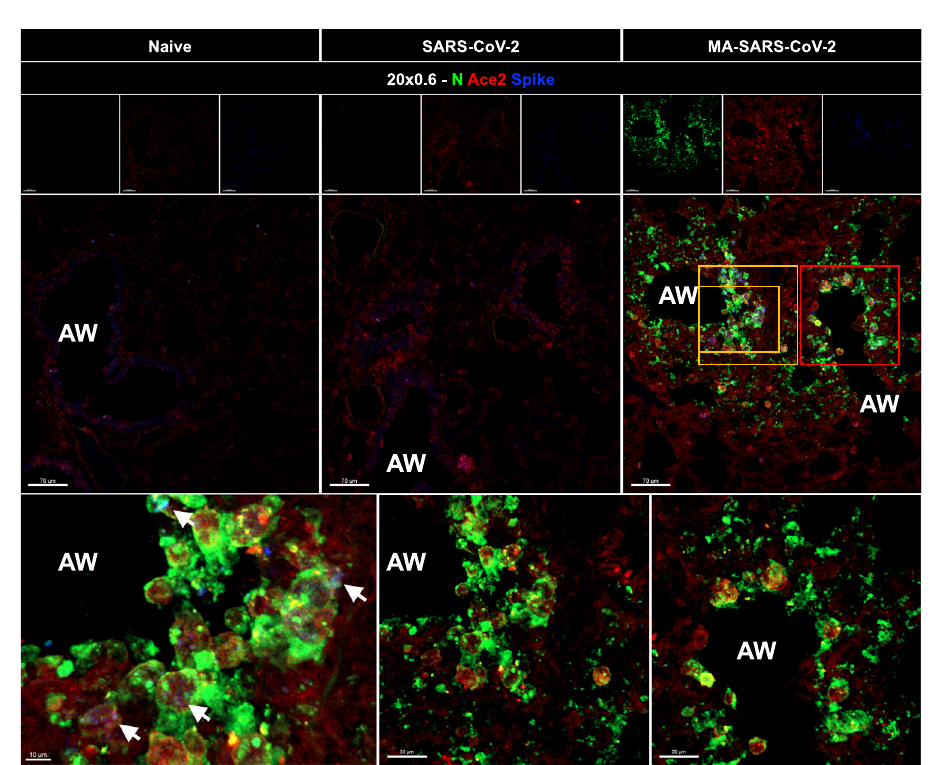
Fig. 3 Multiplex immuno fl uorescence imaging of lung tissues from naïve, WT-SARS-CoV-2, or MA-SARS-CoV-2-infected 129S1 mice immunostained for SARS-CoV-2 N protein (green), ACE2 (red), and SARS-CoV-2 Spike protein (blue). AW: airway. The orange (left and center) and red (right) box is magni fi ed showing N-Protein and Ace2 staining. White arrowheads indicate Ace2 + /SARS-CoV-2 N + /SARS-CoV-2 S + cells. Scale bar: 70, 30, and 10 μ m as indicated in the fi gure panels. N = 4 mice per group and one representative image per group is